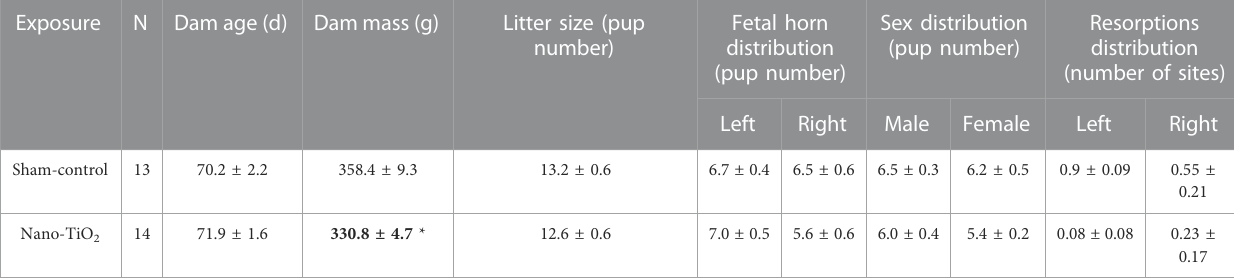
TABLE 1 Dam and litter characteristics include dam age (days), mass (grams), litter size, pup distribution across horns, fetal sex distribution, and resorptions distributions across horns. N is the number of dams. Data are mean ± SEM. *, p ≤ 0.05 vs